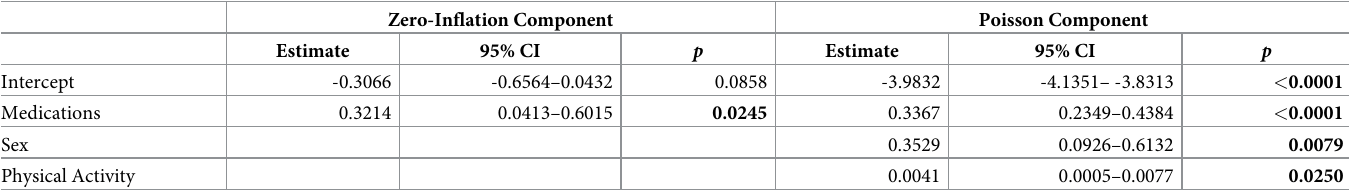
Table 1. Parameter estimates and 95% CI for zero-inflated and Poisson components of the zero-inflated Poisson model.